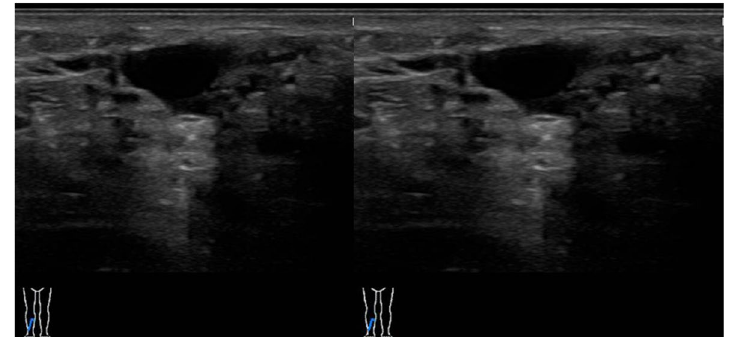
Fig. 2 US imaging of a VM on the right lower leg in a 20-year-old patient